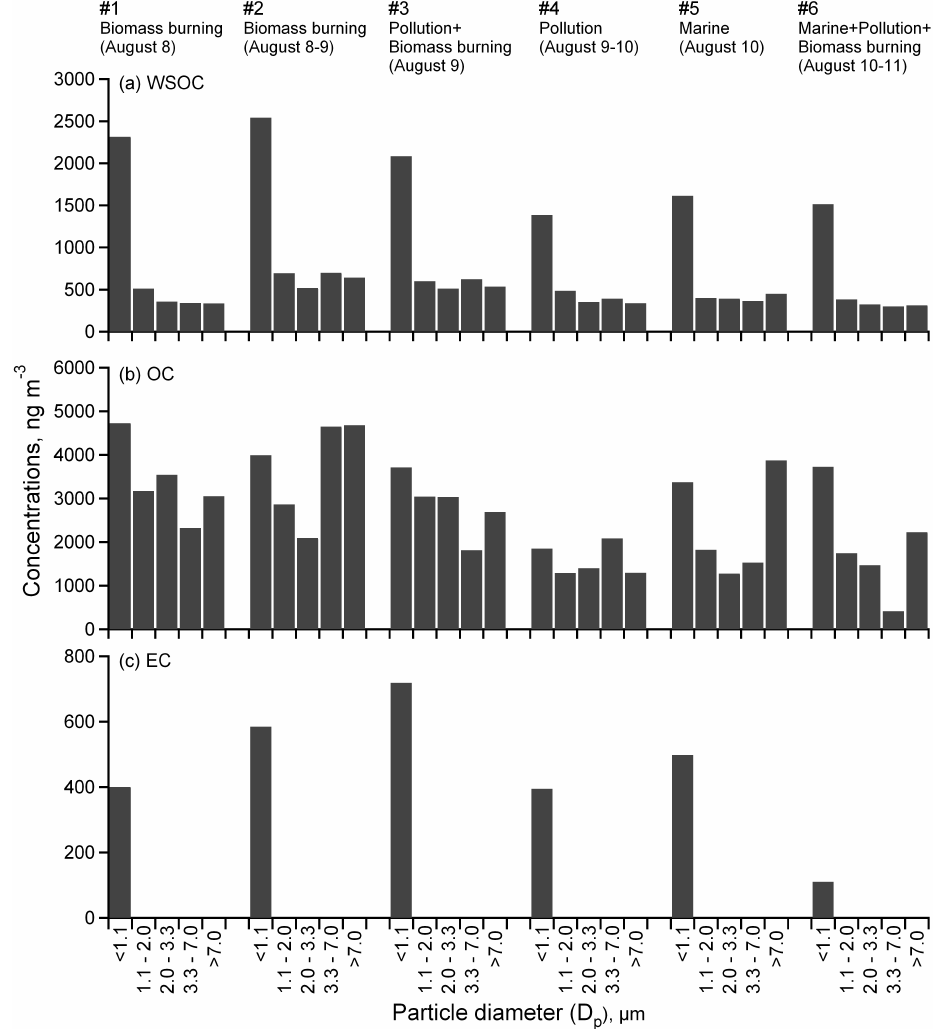
Fig. 9. Size distributions of carbonaceous species in the Sapporo aerosols collected in summer 2005. Table 4. Concentrations (ngm − 3 ) of WSOC, OC, EC and major ions in the size-segregated aerosols from Sapporo, northern